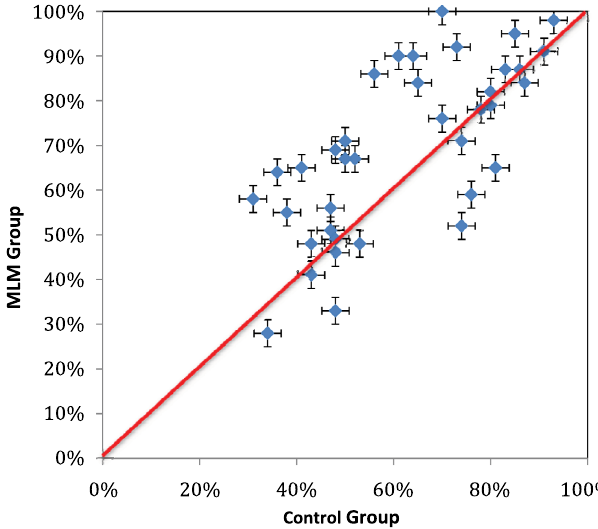
FIG. 2 (color online). Scatter plot of percentage of student correct responses on each of the 39 identical clicker questions in control and MLM classes. Each point represents one clicker question where the average correct responses for the control group and MLM are on the x and y coordinates, respectively. The error bars represent the standard error for each question and the straight line corresponds to x ¼ y .